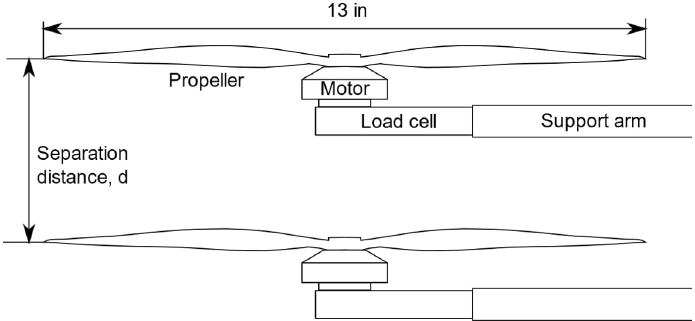
Figure 3. Schematic of coaxial rotor experimental setup built at Rutgers University, Piscataway, NJ, USA.